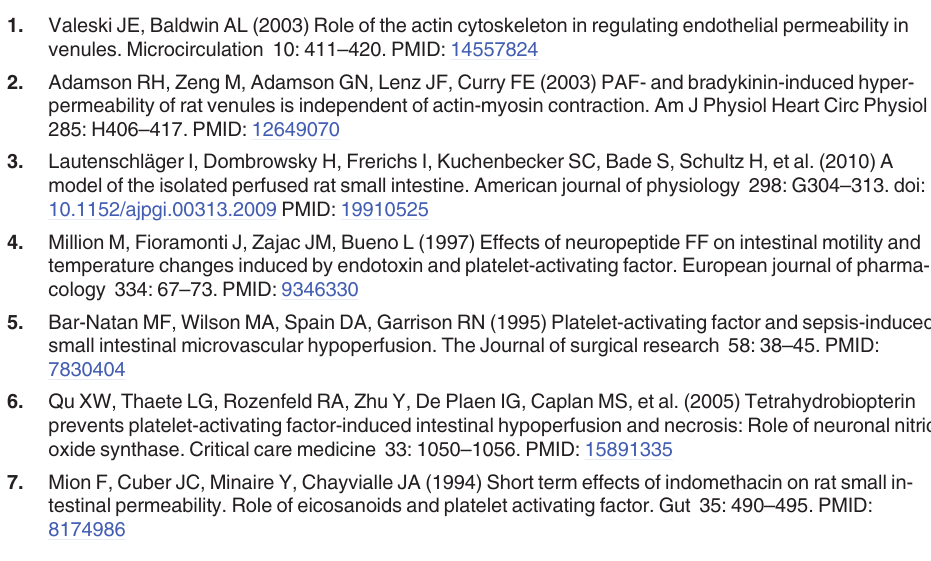
dexamethasone (DEXA, n = 6) or quinidine (QD, n = 8). Statistics were calculated with Krus- kal-Wallis test and Dunn ’ s multiple comparison test; no significant differences versus PAF. S6 Fig. Lactate-to-pyruvate ratio. After 140 minutes of isolated perfusion the lactate-to-pyru- vate ratios were calculated for most experiments. Intestines were stimulated with PAF alone (PAF) or after pretreatment with a PAF receptor antagonist (PAF-RA), without any stimula- tion or treatment (SOL), after pretreatment with COX and LOX inhibitors (COX/LOX-), thromboxane and leukotriene receptor antagonists (TX/LT-), dexamethasone (DEXA) or quinidine (QD). Statistics were calculated with Kruskal-Wallis test and Dunn ’ s multiple com- parison test; (cid:3) p < 0.05 versus PAF. S1 Table. Characteristics of the experimental groups. S2 Table. Composition of